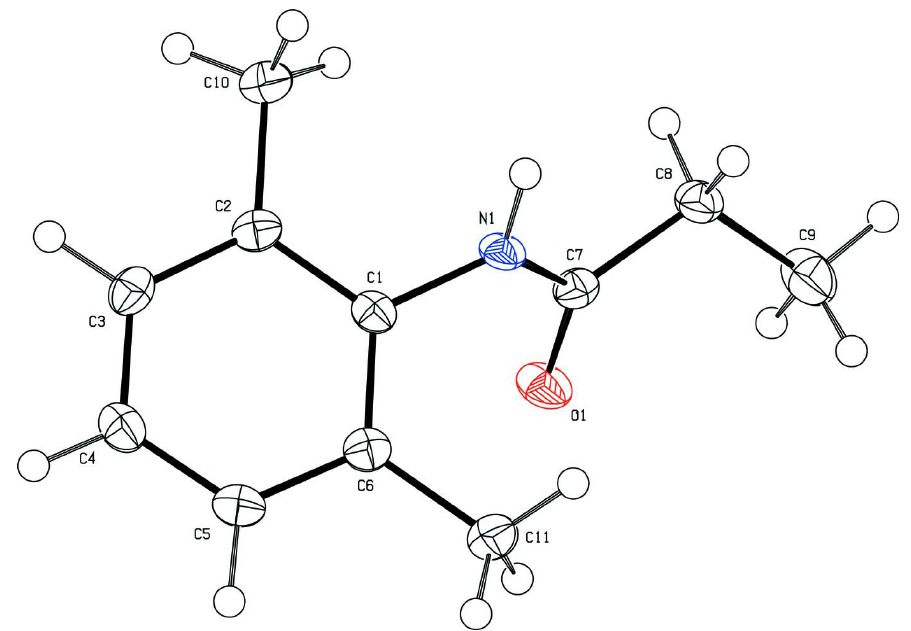
Figure 1 Molecular structure of the title compound showing the atom labelling scheme. Displacement ellipsoids are drawn at the 50% probability level. H atoms are represented as small spheres of arbitrary